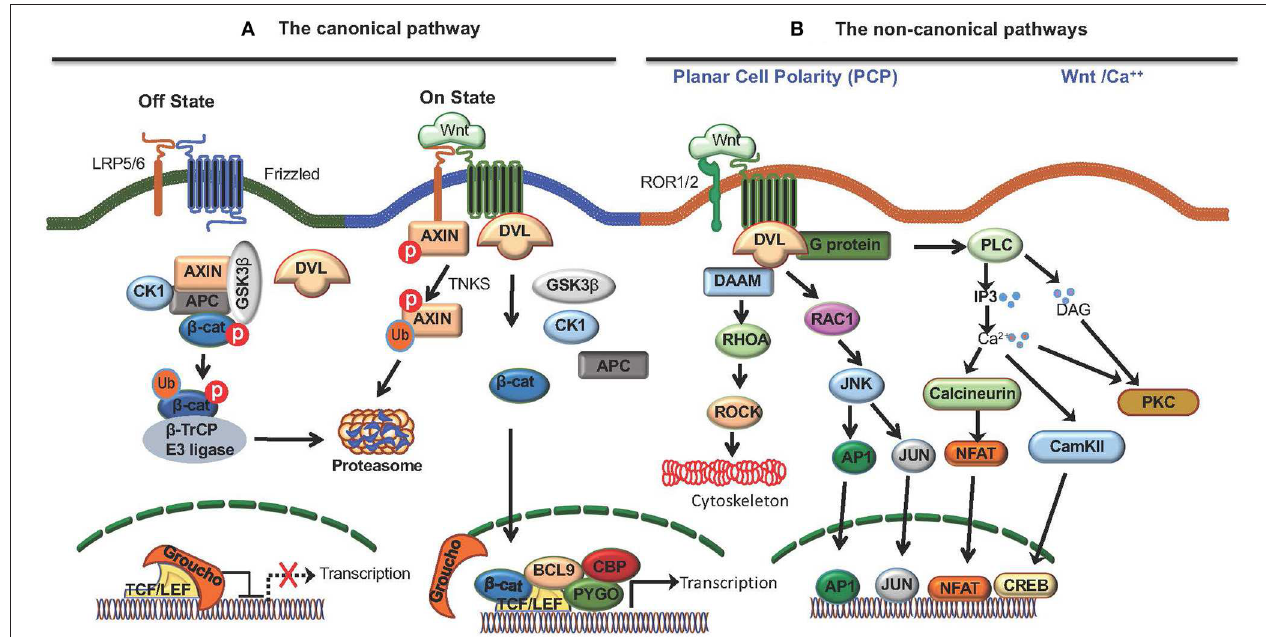
FIGURE 1 | The Wnt signaling pathways. Wnt ligands bind to Frizzled (Fzd) receptors and activate the canonical Wnt pathway that is dependent on co-receptors LRP5/6 and β -catenin, and the non-canonical Wnt pathway that is independent of β -catenin. (A) The canonical Wnt pathway. In the absence of Wnt signaling (off state), free β -catenin in the cytoplasm is sequestered by adenomatus polyposis coli (APC)/Axin/CK1 α /GSK3 β complex, leading to its phosphorylation by glycogen synthase kinase 3 β (GSK-3 β ) which targets it for degradation via the ubiquitin–proteosome pathway. Wnts binding Fzd receptors and LRP5/6 co-receptors (on state) recruits DVL resulting in disassembly of (APC)/Axin/CK1 α /GSK3 β complex, and the accumulation and translocation of unphosphorylated β -catenin to the nucleus. β -catenin translocation to nucleus results in the displacement of the co-repressor Groucho on the TCF/LEF transcription factor and the recruitment of co-activators, such as BCL9, CBP, and PYGO resulting in the transcription of target genes. Moreover, cytoplasmic TNKS ubiquitinates Axin, targeting it for proteasomal degradation and causing disassembly of the β -catenin destruction complex. (B) Wnts also activate non-canonical pathways, such as the planar cell polarity pathway and the Wnt-Ca ++ pathway. The planar cell polarity pathway regulates cytoskeletal organization through Rhoa and Rock whereas the Wnt-Ca ++ pathway activates several transcription factors, such as NFAT, AP1, JUN, CREB by β -catenin-independent